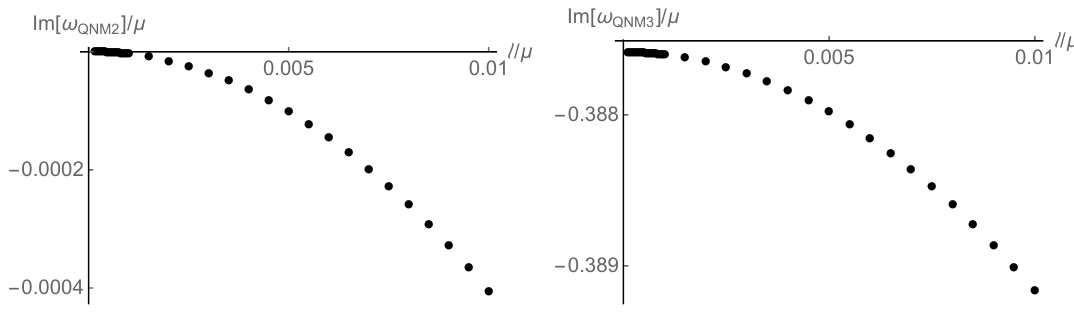
Figure 1 . Second and third purely imaginary QNMs for ( T=(cid:22); k=(cid:22); (cid:21) ) = (0 : 1 ; 0 : 01 ; 0). The (cid:12)rst QNM (not depicted) stays (cid:12)xed at the origin as ‘=(cid:22) is varied. Left: QNM 2 is gapped for ‘ 6 = 0 and becomes gapless for ‘=(cid:22) ! 0. Right: QNM 3 remains gapped as ‘=(cid:22) ! 0. where (cid:15) , p and (cid:26) are the energy density, the pressure (identi(cid:12)ed from the renormalized on-shell action) and the charge density